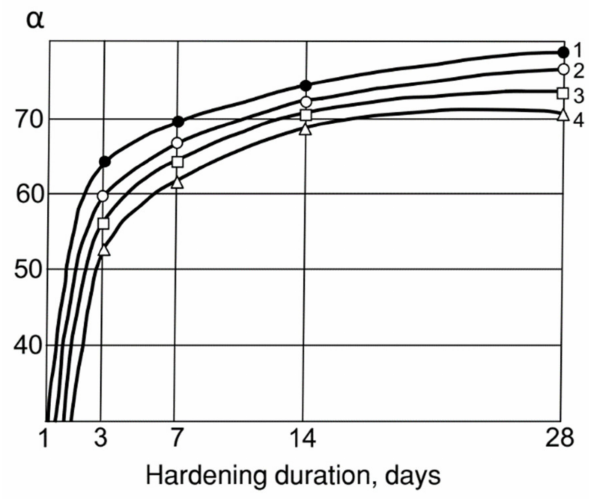
Figure 4. Influence of MK, fly ash and their mixtures on the degree of hydration ( α ). cement: 1—30% MK; 2—30% AMAd (30% MS: 70% Ash); 3—30% fly Ash; 4—CEM